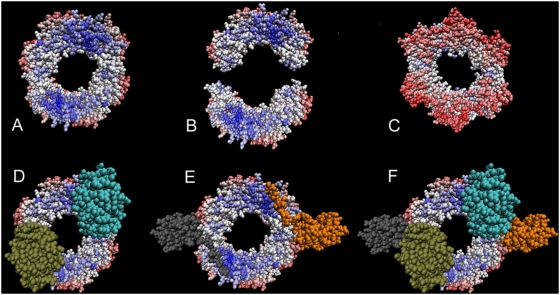
JET prediction of multiple interaction sites based on conservation
signals, and known binding complexes.
 of Escherichia coli DNA polymerase
III holoenzyme; the PDB file 2pol contains the two homodimeric chains.
Top: Complex shown in (A) and (C) is formed of two monomers which are
shown slightly separated and inclined away from the viewer in (B).
Conserved residues are colored from blue (most highly conserved) to
white, and non-conserved residues are colored from white to red (no
trace of conservation being found). Note the conserved zones at the
contact surfaces between the two monomers (visible for the upper monomer
in (B)). The complex shows a conserved face (A) and a non-conserved one
(C). Bottom: the conserved face is in contact with two other chains (PDB
files 1jql:B (D) and 1unn:CD (E)) which are not included in the PDB file
2pol. The results of JET can be understood when chains 1jql:B and
1unn:CD are added to 2pol giving meaning to the conserved sites
detected.